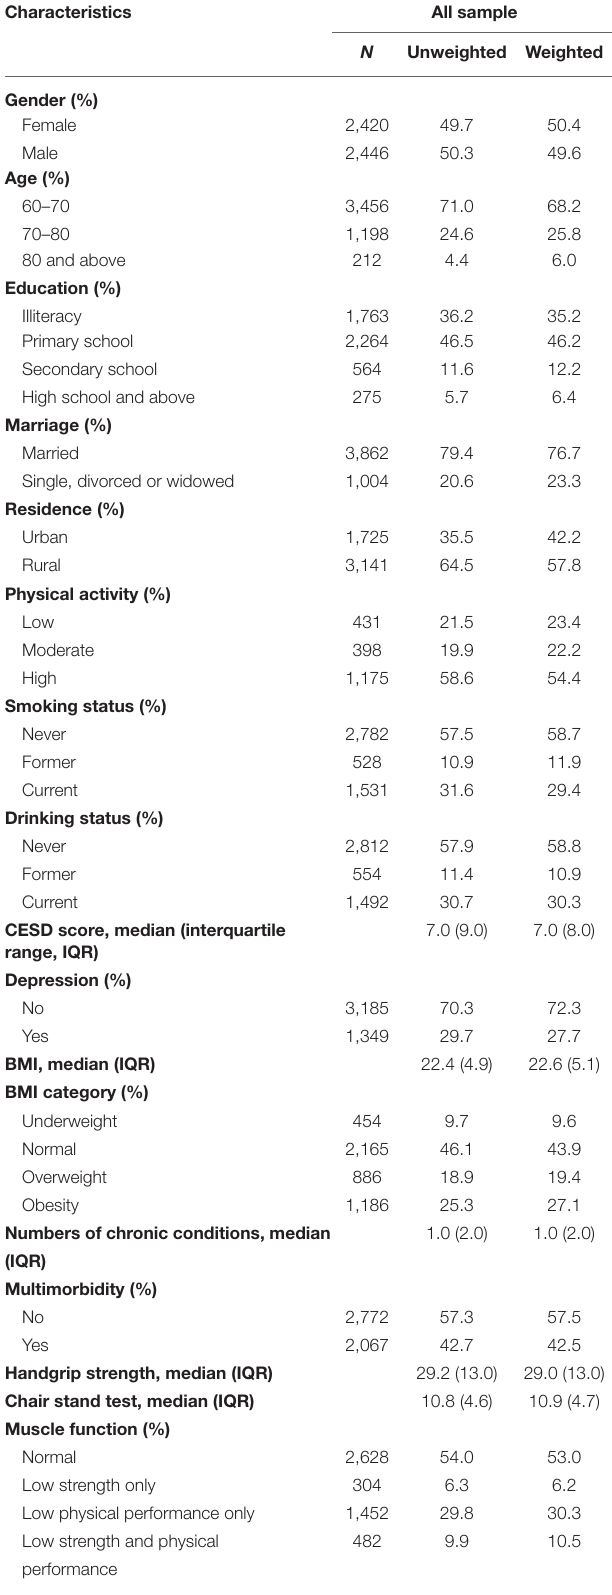
TABLE 1 | Characteristics of participants at